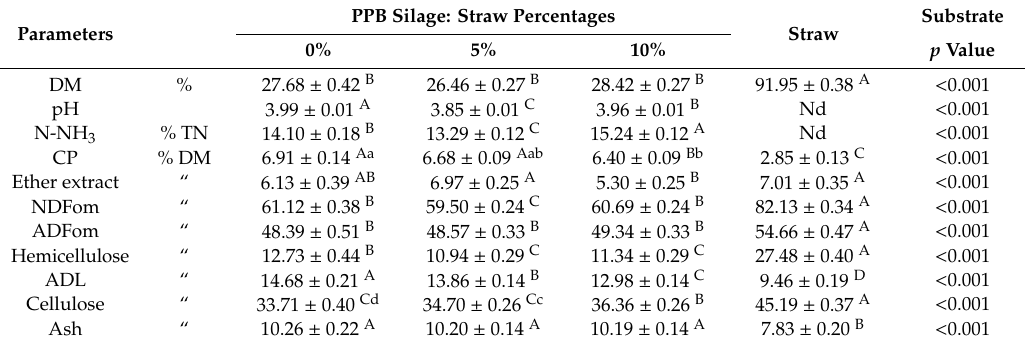
Table 1. Micro silos evaluation and chemical composition of by-products of prickly pears (PPB) silages and wheat